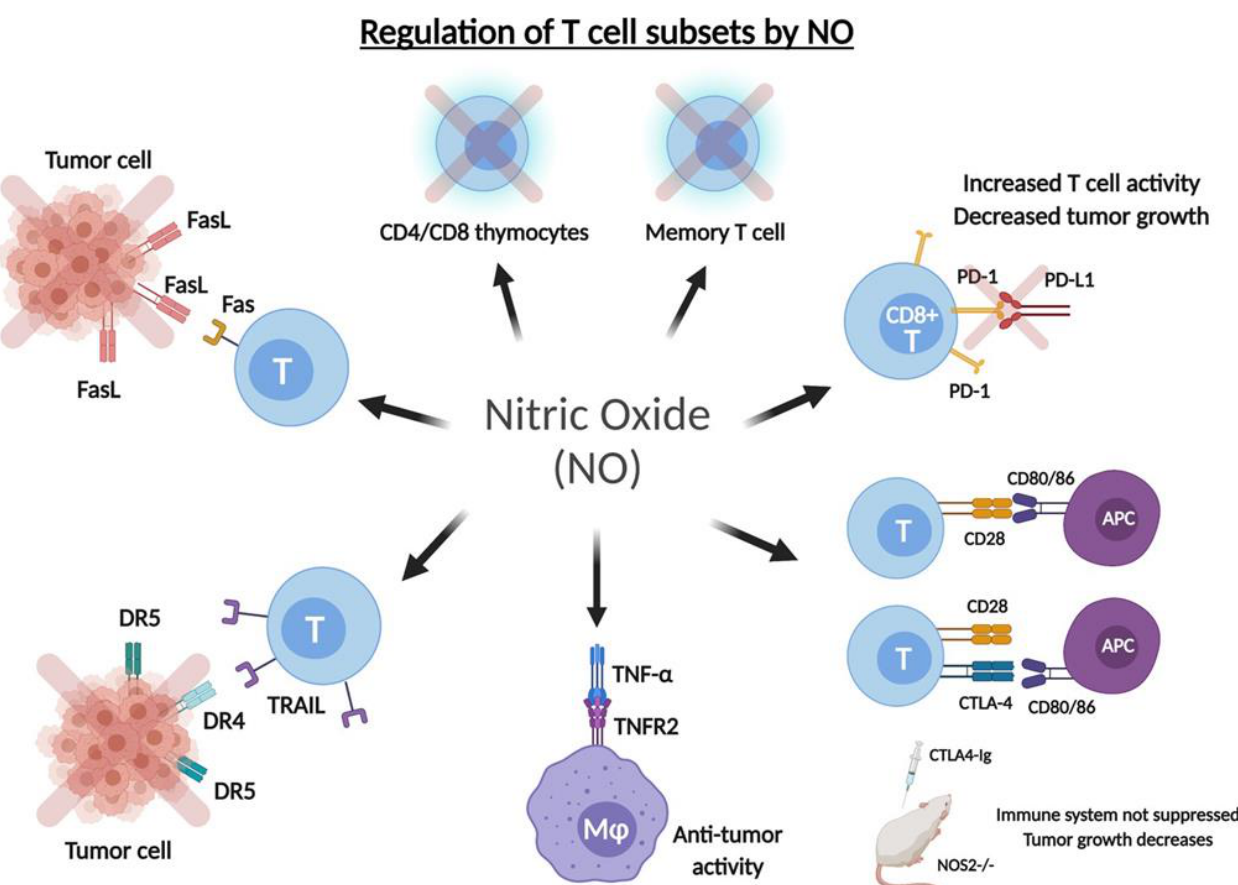
Figure 2. Regulation of T cell subsets by .NO. .NO is involved in the regulation of various Tcell subsets and contributes to their role in disease. Blocking PD-1/PD-L1 interactions may be due, in part, to increased levels of .NO, resulting in activation of T cell activity and subsequent inhibition of tumor growth. Interactions between CTLA4 and the CD80/CD86 ligands is found to be immunosuppressive; however, administration of the CTLA4-Ig was found to be ineffective for immunosuppression in .NOS2-deficient mice, suggesting a role of .NO in CTLA4-mediated suppression of T cell activity. .NO production is necessary for the interaction between TNF- α and TNFR2 in suppressing tumor growth. .NO production sensitizes tumor cells to FasL-mediated apoptosis, whereas inhibition of .NO evades FasL-mediated apoptosis and promotes tumor progression. Increased .NO production leads to upregulation of the TRAIL ligand as well as its receptors to sensitize tumor cells to TRAIL-mediated apoptosis. .NO is found to reduce expression of CD4 + /CD8 + thymocytes as well as memory T cells.